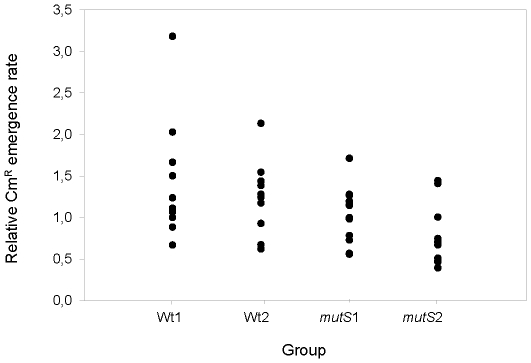
Mutation rates within leading and lagging strands of replication.CmR emergence rates within the leading and lagging strands of replication in wild-type (Wt1 and Wt2) and mutS (mutS1 and mutS2) backgrounds.